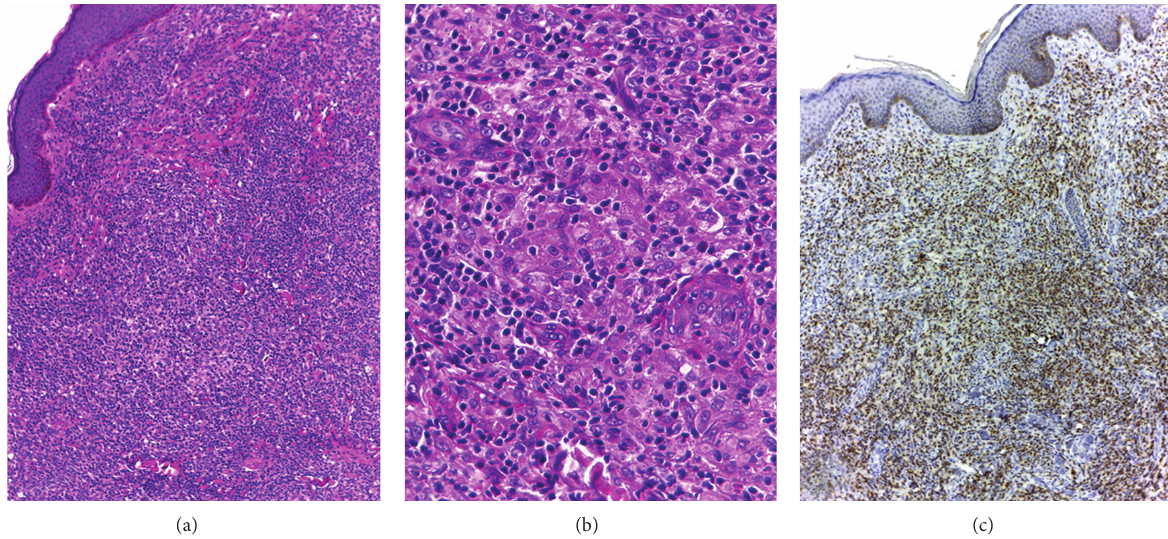
Figure 7: Pathological diagnosis : routine hematoxylin-eosin stained section of the skin of abdominal wall (a and b) revealed lymphocytic and granulomatous infiltration, with epithelioid macrophages and sparse eosinophils (original magnification: [100x] and [400x], resp.). Immunohistochemical study (c) showed positivity for CD3, a T-cell marker (original magnification: